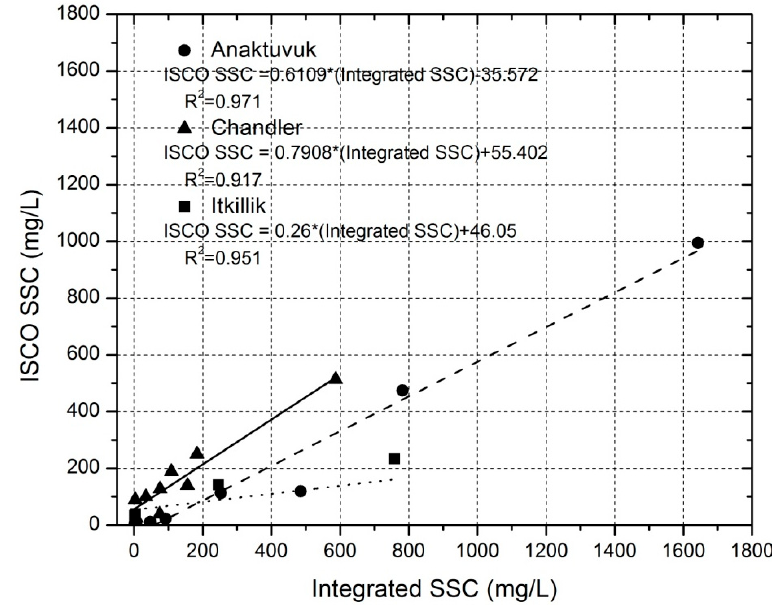
Figure 3. Relationships between suspended sediment concentration (SSC) calculated from Isco and integrated samples. Anaktuvuk n = 6; Chandler n = 9; Itkillik n = 4.